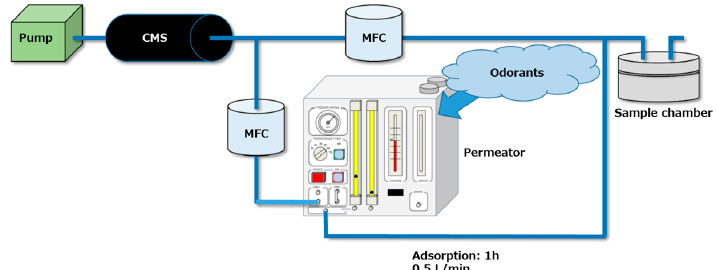
Figure 4. Adsorption experiment system. CMS: carbon molecular sieve column for obtaining clean air. MFC: mass flow controller. Sample adsorbents were placed in the sample chamber.